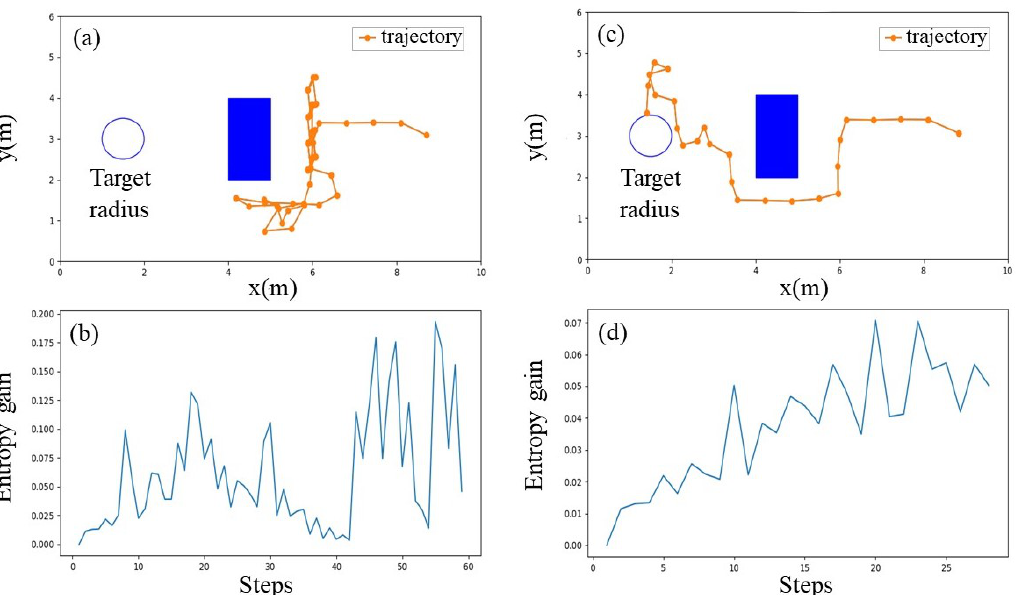
Figure 2. ( a ) Trajectory of a failed search when a deadlock occurs. ( b ) Information entropy gain in the case of deadlock. ( c ) Trajectory of a successful search without a deadlock. ( d ) Information entropy gain in the absence of